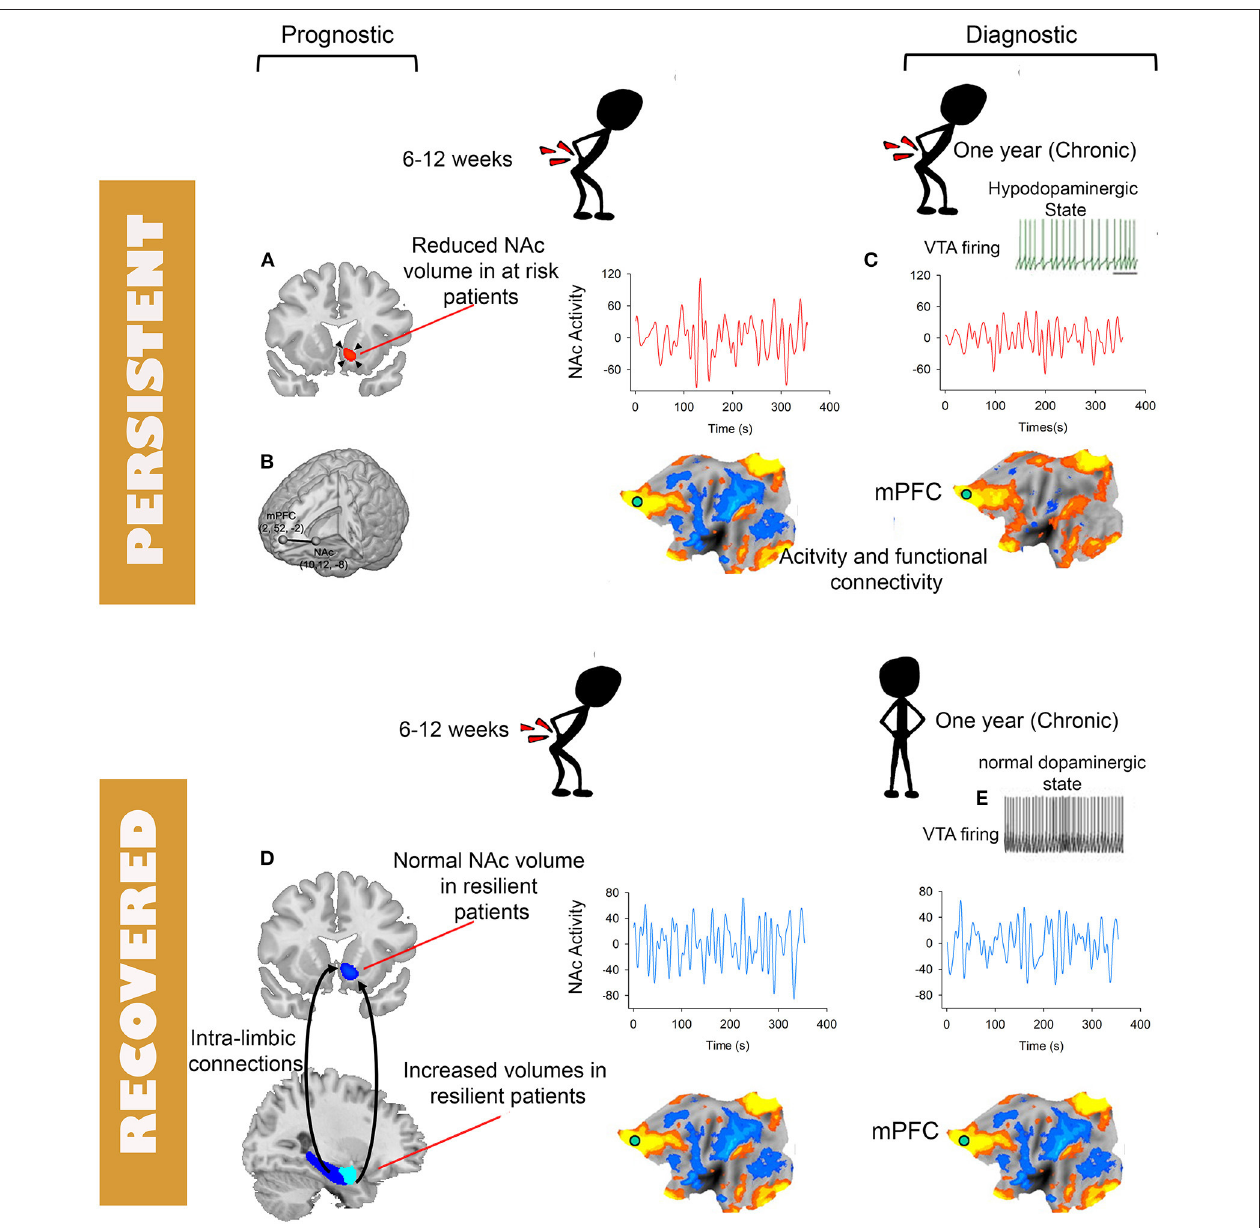
FIGURE 2 | Schematic depiction of brain tissues and modality with potentials for becoming biomarkers for diagnosis and prognosis of chronic pain. Prognostic biomarkers (A,B,D) and diagnostic biomarkers (C) . The flattened brains are symbolic of various functional plasticity observed in chronic pain including changes in activity, connectivity or multi-variate patterns. Except for the NAc to mPFC functional connectivity (B) available prognostic biomarkers are derived from structural MRI (A,D) . (C) Depiction of loss of low-frequency fluctuations of NAc activity. (E) Decreased firing of the ventral tegmental area and the associated hypo-dopamnergic state observed in preclinical and clinical studies of chronic